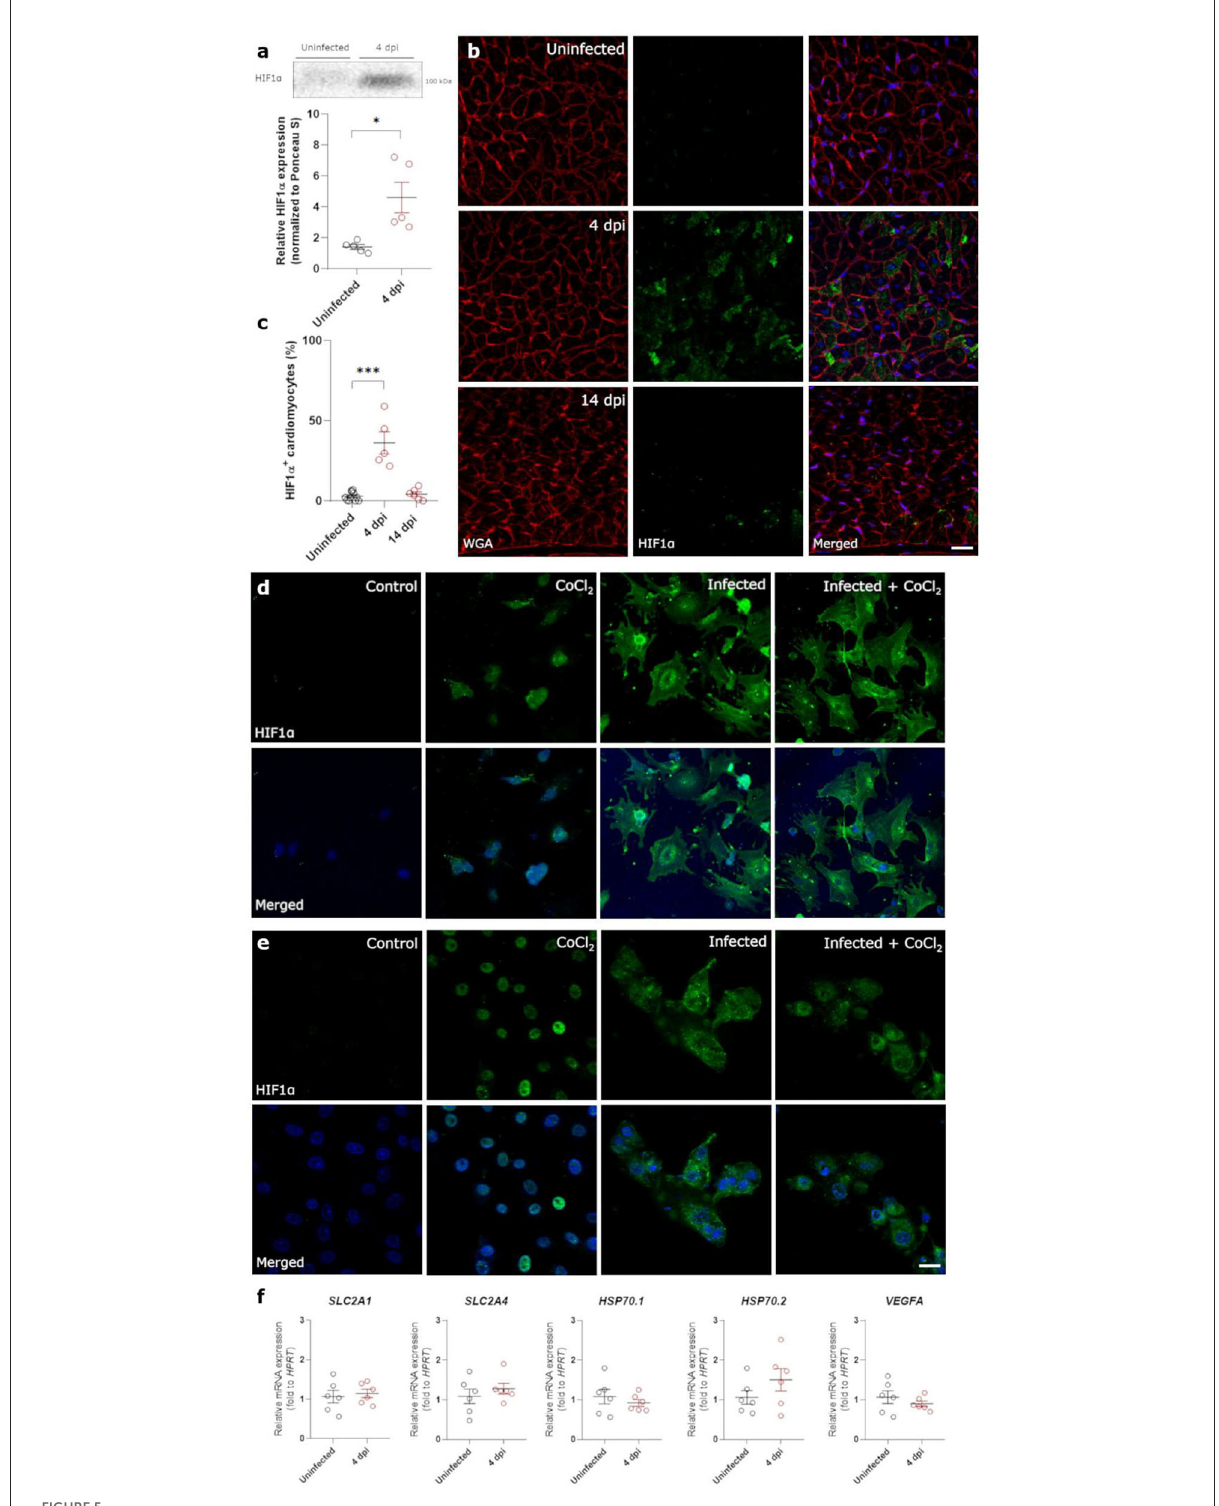
FIGURE5 SARS-CoV-2 infection prevents translocation of HIF1 α in hamster hearts and in vitro . Twelve week old hamsters were infected with SARS-CoV-2 virus and sacrificed at 4 dpi, at the peak of viral load, and at 14 dpi. (a) HIF1 α expression in protein lysates of 4 dpi hamster